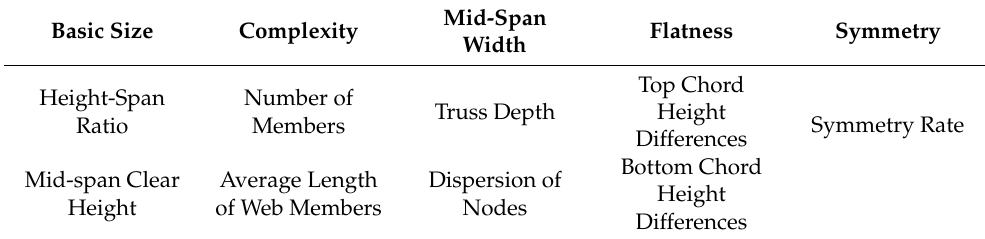
Table 1. Feature vector. Basic